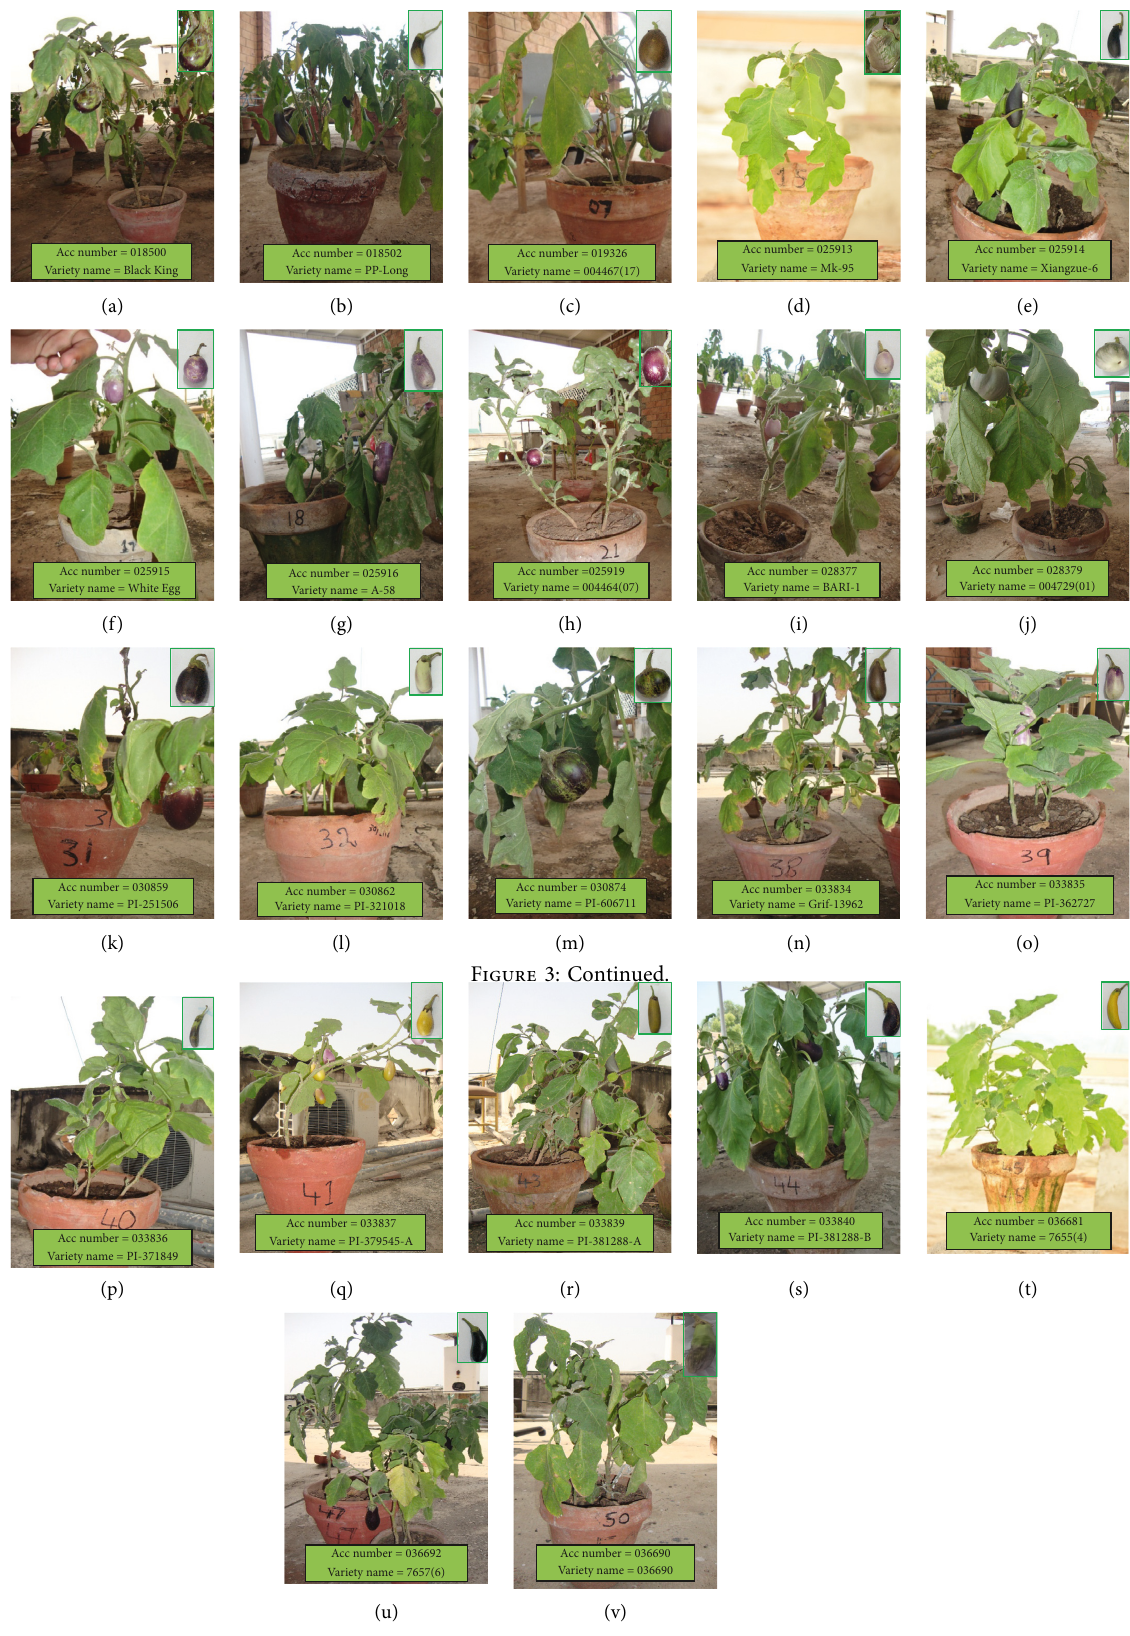
Figure 3: Fruiting stage of 22 eggplant